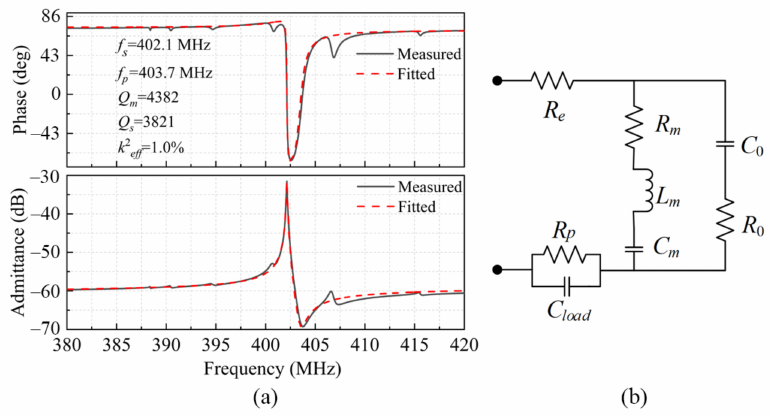
Figure 6. ( a ) The measured and fitted admittance diagram and phase diagram of the LWR with the IDT period of 12 µ m; ( b ) the MBVD model used to extract the LWRs’ equivalent electrical parameters.